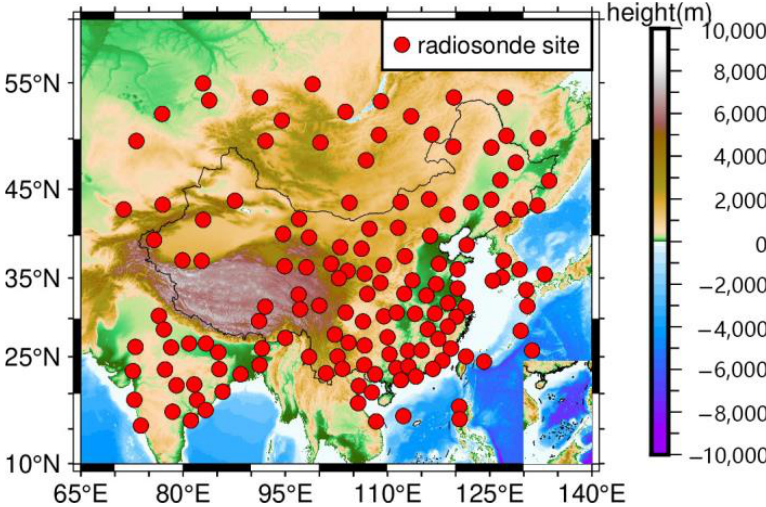
Figure 1. Distribution of the study area and the selected radiosonde sites.